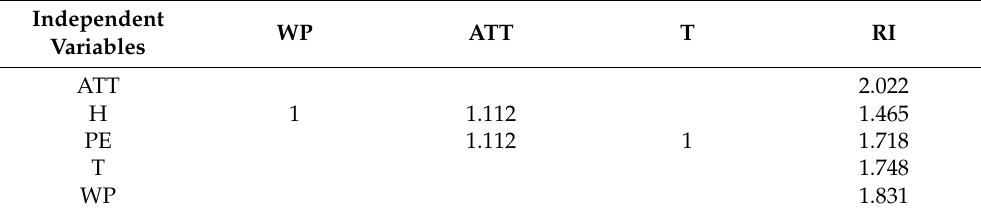
Table 5. Inner VIF Values.